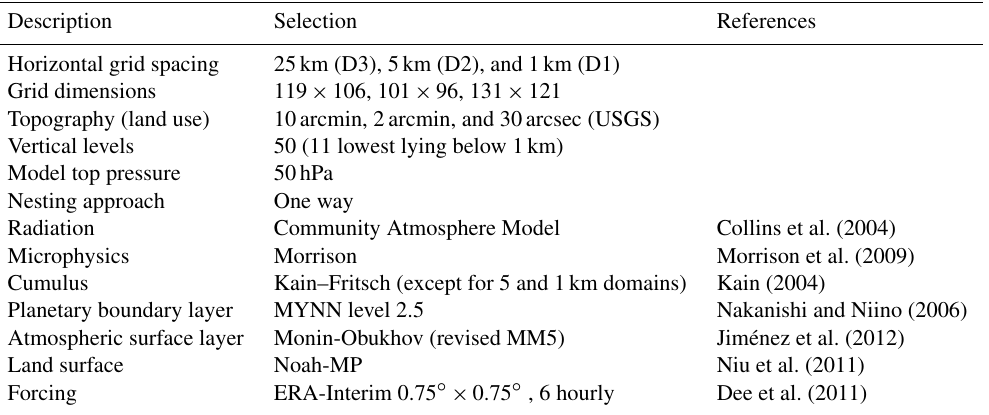
Table 1. Description of model